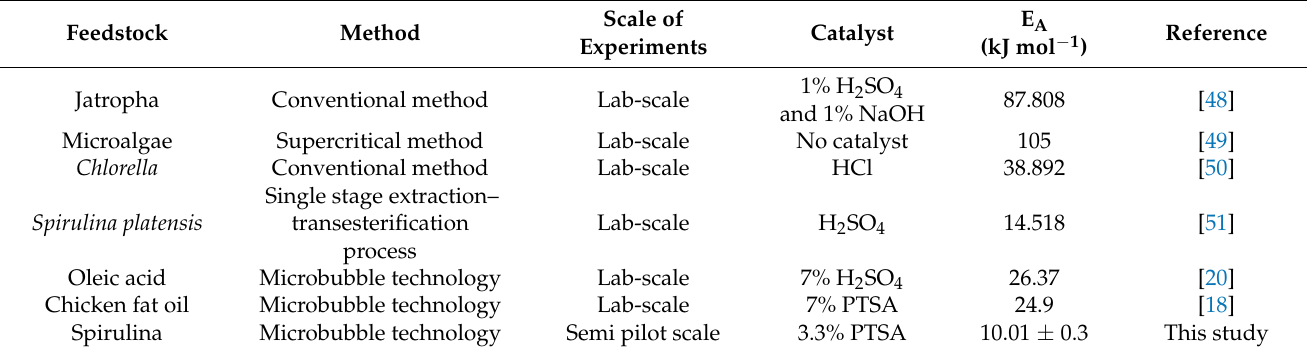
Table 4. Comparison of activation energy with different biodiesel feedstocks .